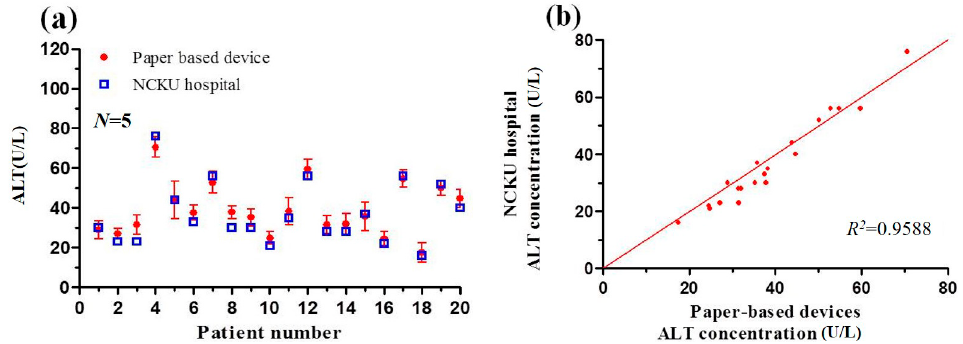
Figure 9. ( a ) ALT concentration detection results obtained using paper-based analytical device and traditional spectrophotometric method from NCKU hospital; ( b ) Correlation between spectrophotometric results for ALT concentration and paper-based analytical device results. Table 2. Comparison between colorimetric method and spectrophotometric method for detection of AST and ALT.